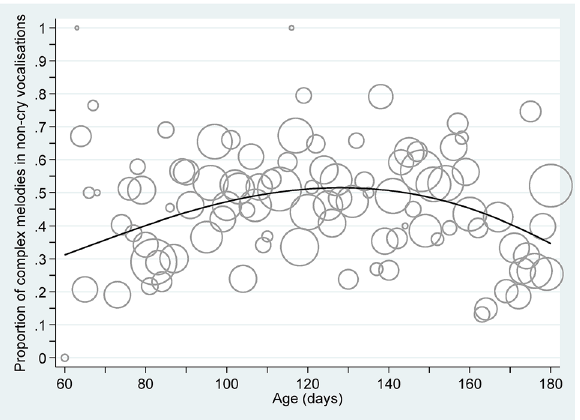
Figure 3. Bubble plot of the proportion of complex melodies in non-cry vocalisations over age together with the mean prediction line derived from the final multi-level mixed effects logistic regression model. Note: the bubble size gives the relative number. Here, the median bubble size represented n = 102, with Q1 = 45, Q3 = 143 and range: